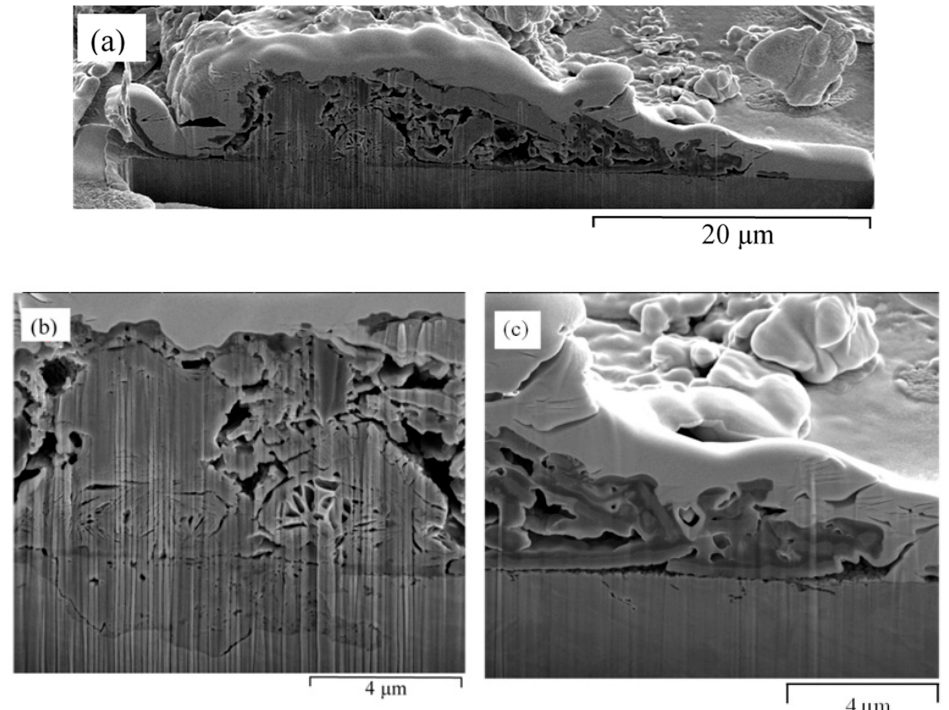
Figure 15. FIB-SEM cross-section of more common features of carbon steel exposed to the pure culture of IRB in the inorganic medium (i.e., Postgate C without organic components) for 168 h: ( a ) overview of a cross-section under an area of a corrosion deposit, ( b ) undercutting pitting has occurred under the biofilm, and ( c ) localised corrosion penetration and biofilm.